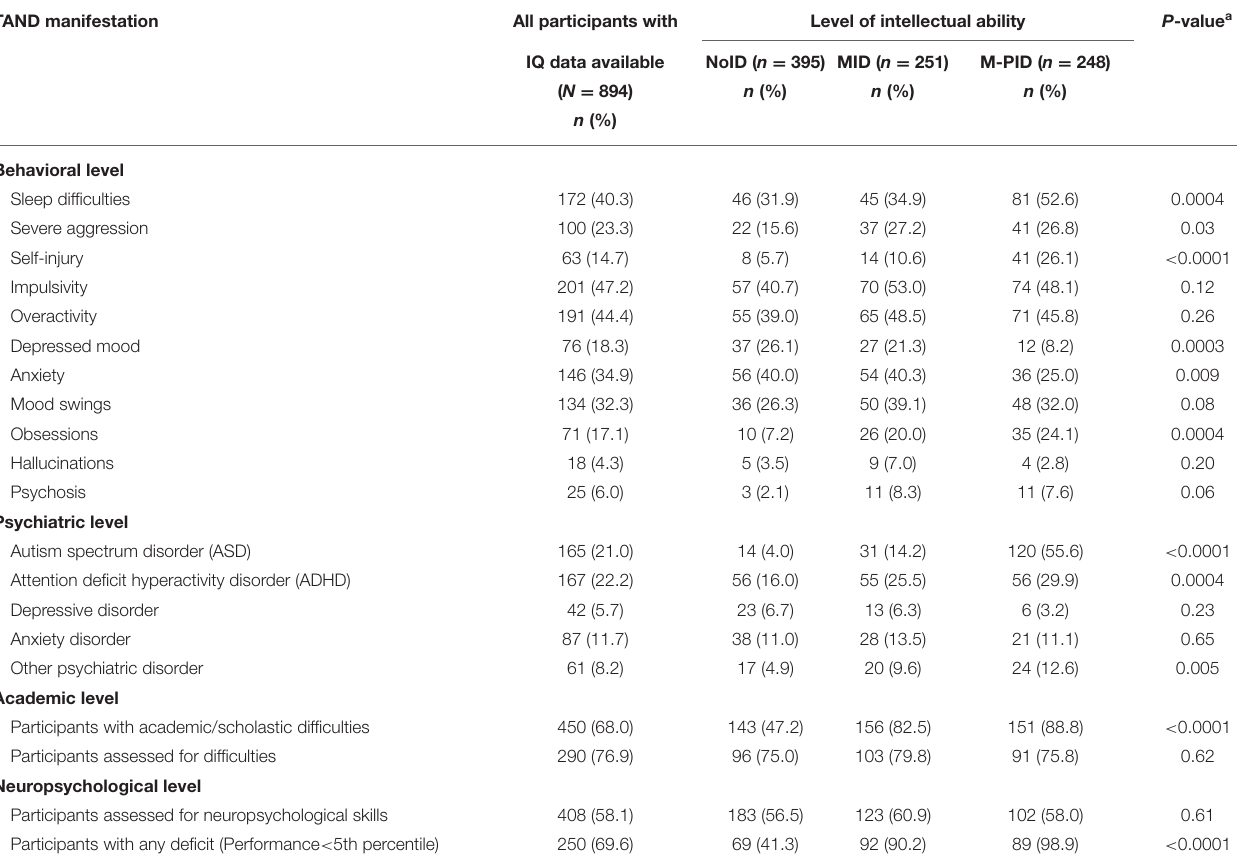
TABLE 2 | TAND manifestations in all participants with available IQ data stratified by levels of intellectual ability (noID [IQ > 70], MID [IQ 50–70] and M-PID [IQ < 50]). TAND manifestation All participants with Level of intellectual